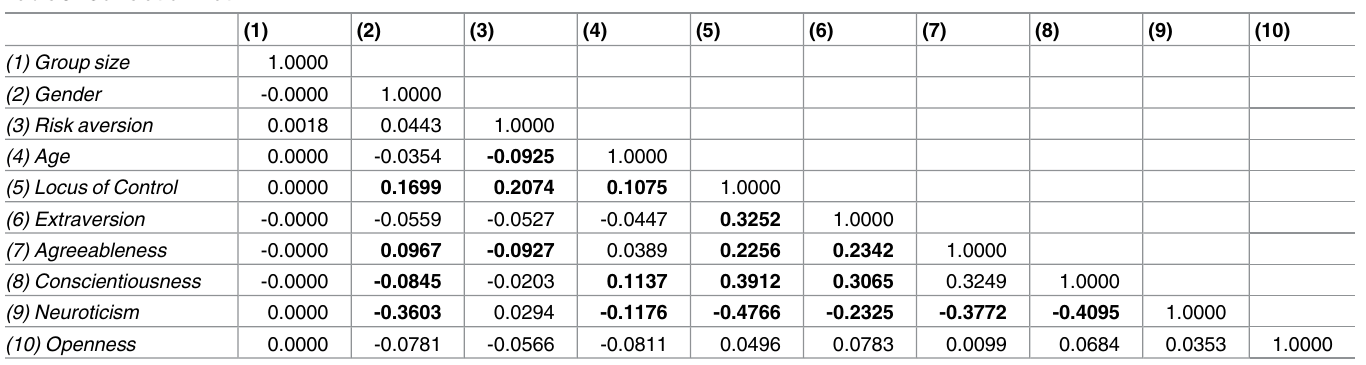
Table 3. Correlation matrix.